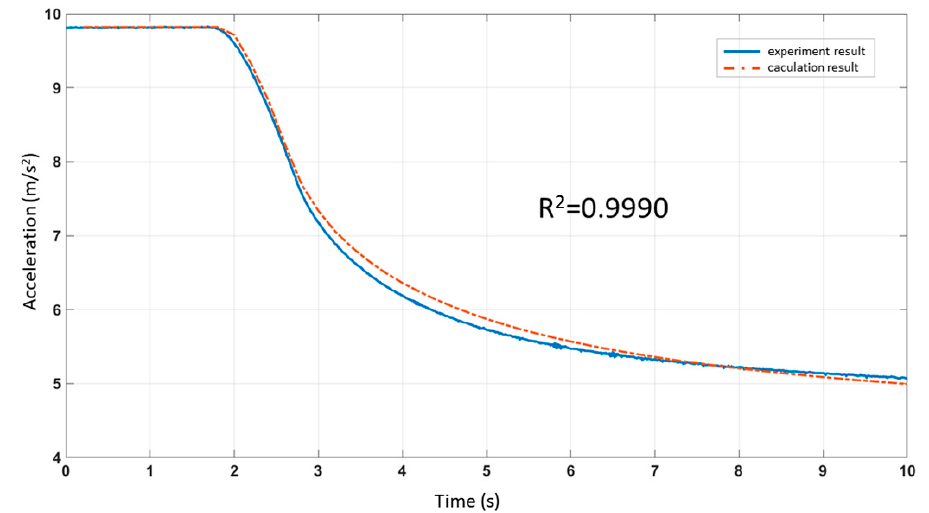
Figure 6. Comparison of the experimental data and mathematical model results under the sweeping amplitude acoustic attack.